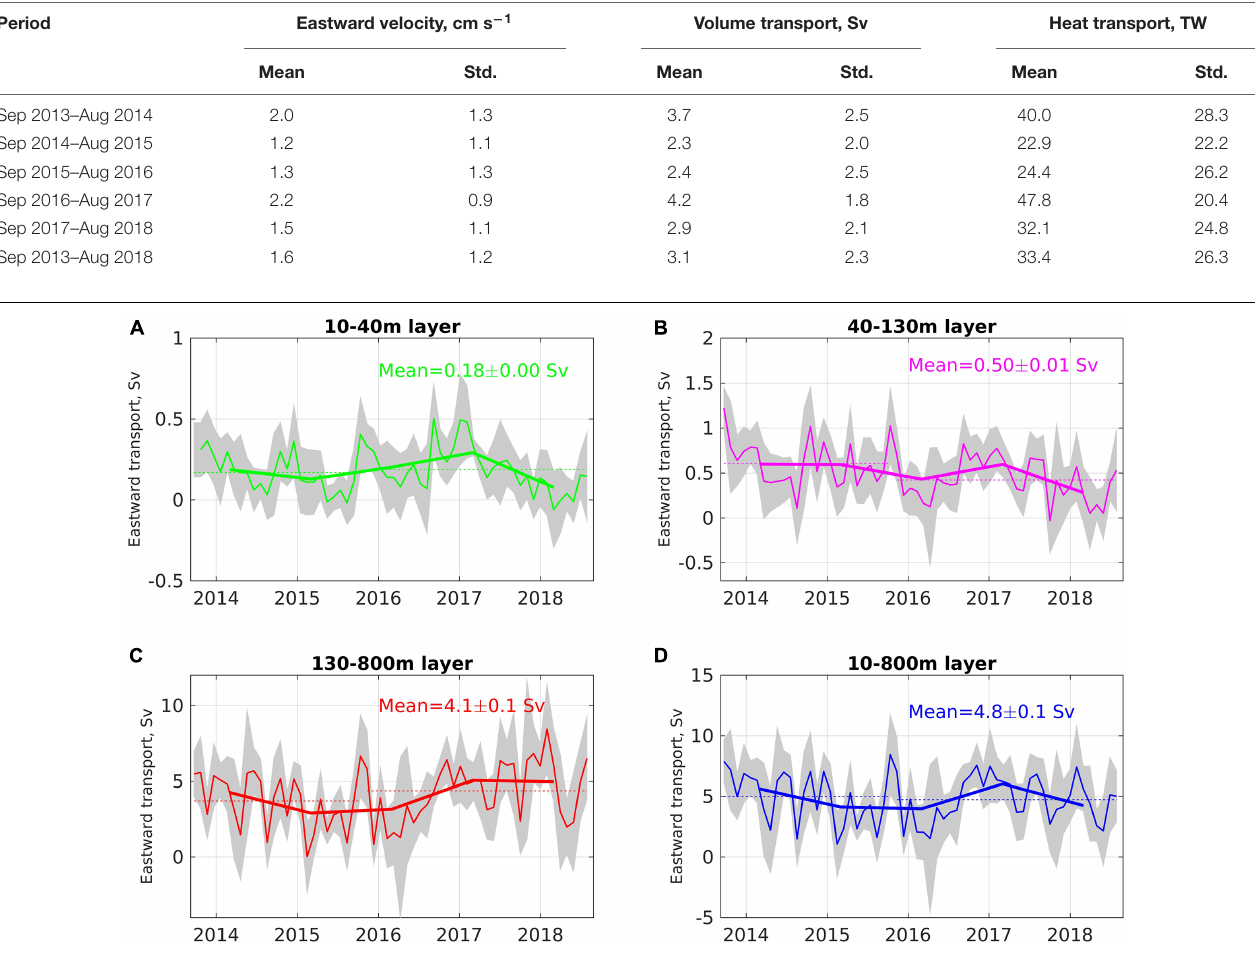
TABLE 4 | Means and standard deviations (Std) of the eastward volume and heat transports in the AW layer across the Laptev Sea slope estimated from mooring observations in 2013–2018. Period